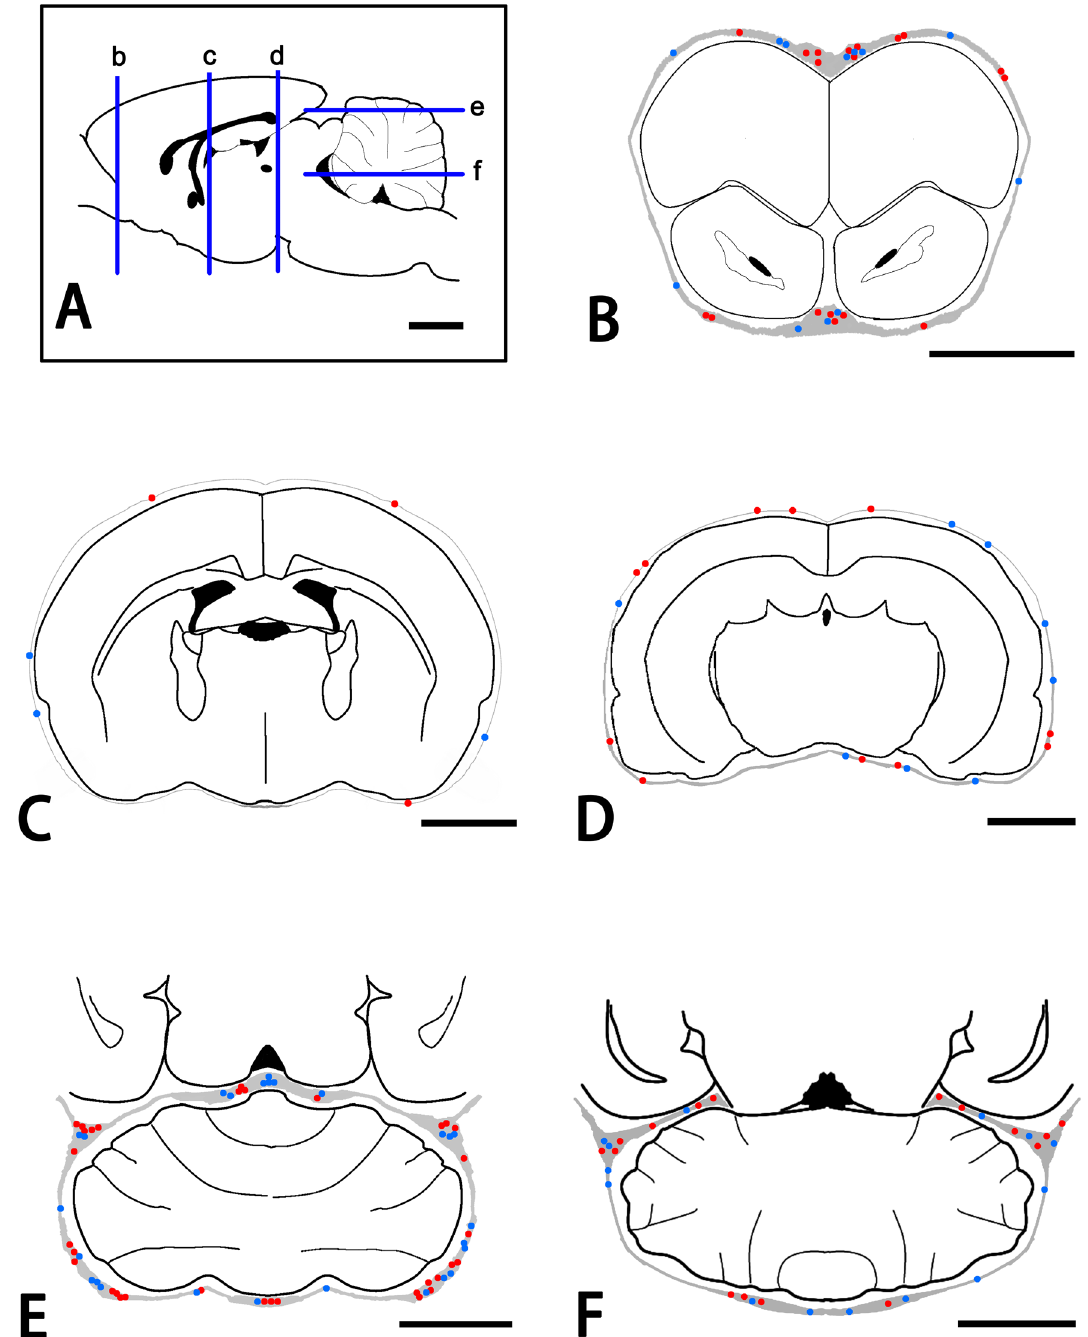
Figure 3. Schematic drawings for the distribution of GAL-ir cells in the dura mater. Panels ( B – F ) indicate the frontal ( B – D ) and horizontal ( E , F ) sections of the brain obtained from the cross sections of b, c, and d, and e and f, respectively. Red and blue circles indicate round and oblong cells with GAL-immunoreactivity, respectively. Bars = 3 mm ( A – F